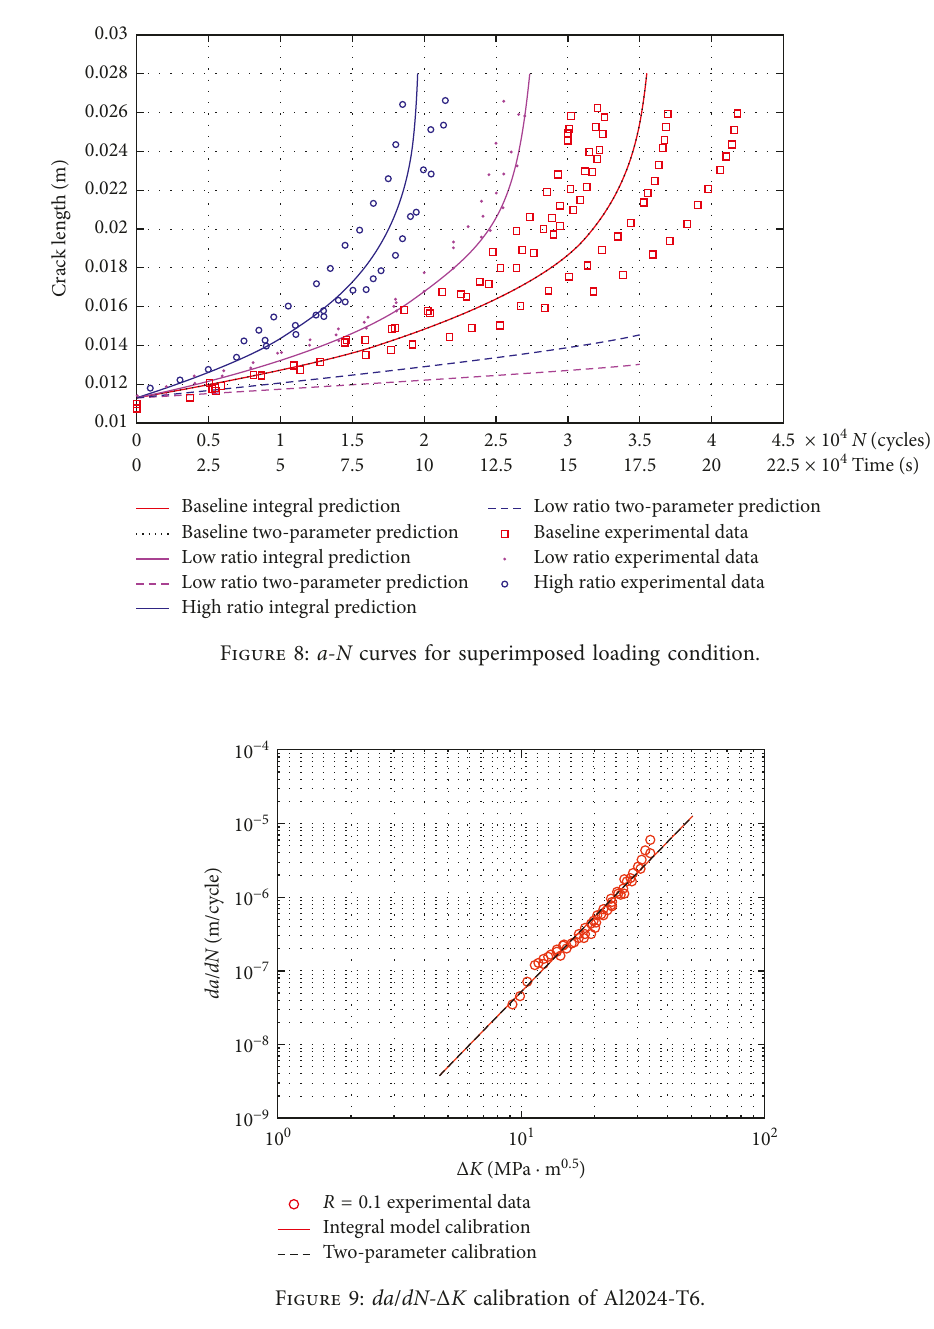
K calibration of Al2024-T6. Δ